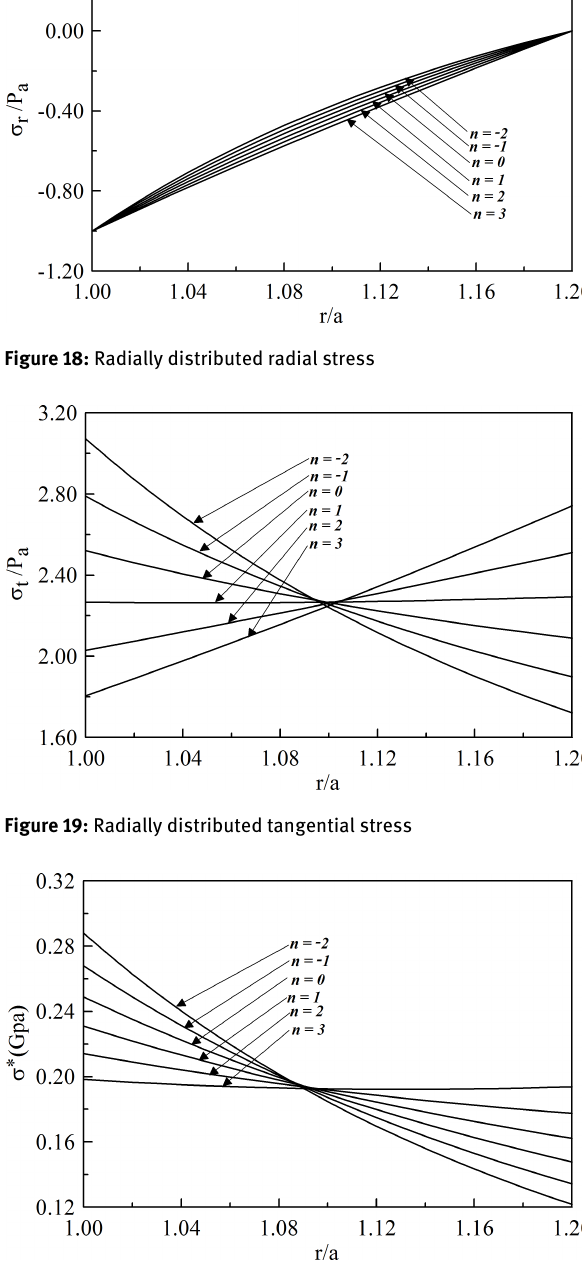
Figure 20: Radially distributed von-Mises